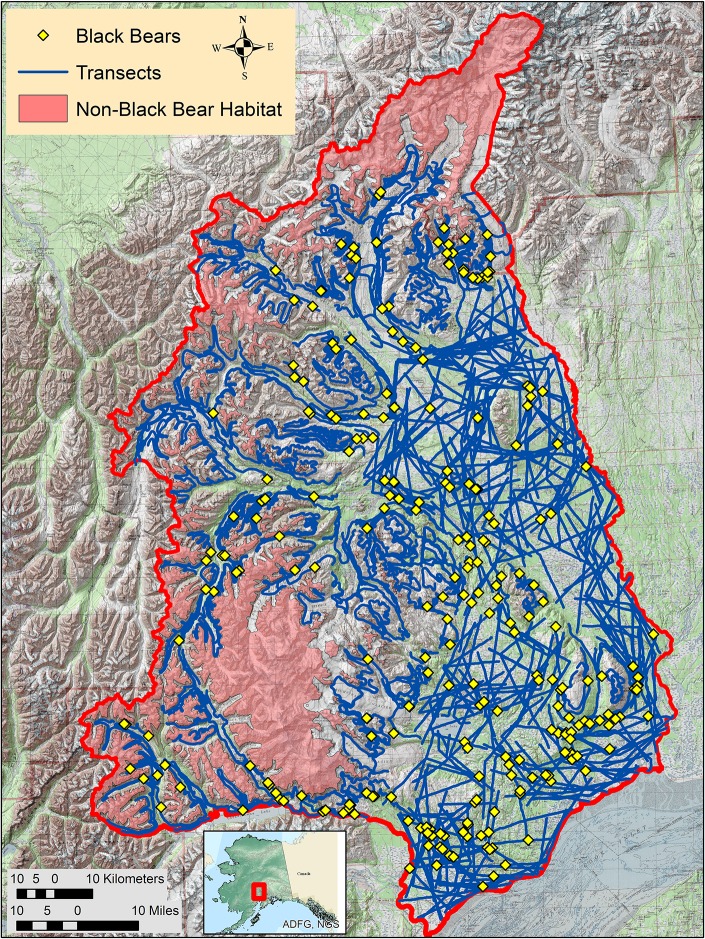
The Skwetna study area of South-Central Alaska that was used in a 2007 aerial distance sampling survey of black bears.The study area is enclosed by the red border and Cook Inlet to the southeast. Red-shaded areas within the study area denote locations that were above 1,067 m in elevation that were classified as non-black bear habitat. Yellow triangles denote the location of detected black bear groups. The blue lines denote the actual flown transects, with contour transects flown in mountainous terrain and straight transects that contain a midpoint hinge being flown in the lower-elevation, flat terrain.